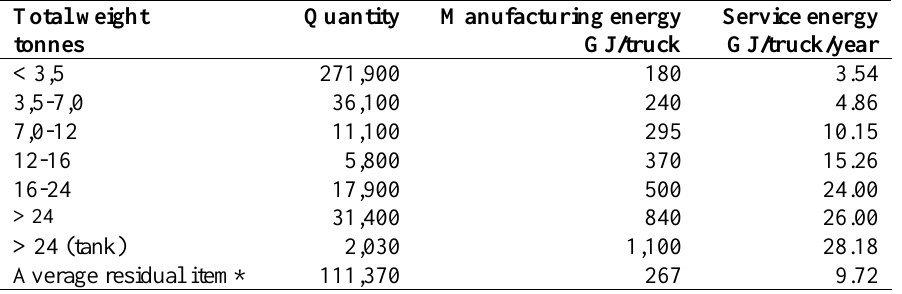
Table 3. Trucks in Sweden distributed over weight